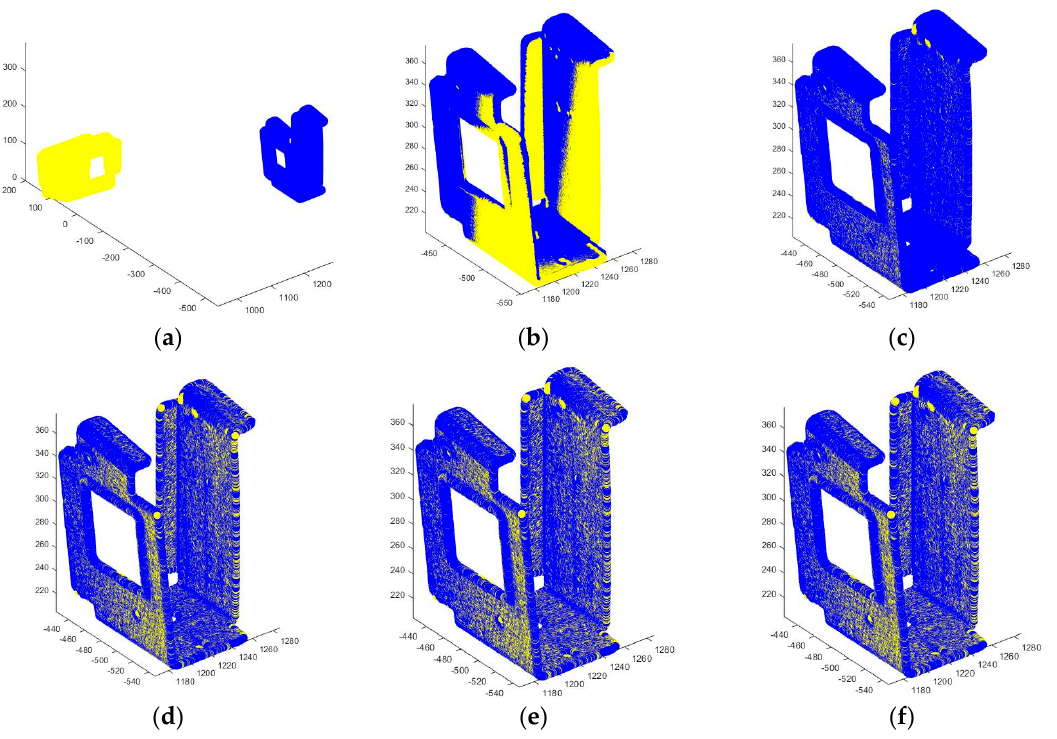
Figure 8. Point cloud fine registration experiment. ( a ) is the initial point cloud data position of the vehicle part, ( b ) is the coarse registration result of FPFH, ( c ) is the fine registration result of ICP, ( d ) is the fine registration result of Harmony search (HS), ( e ) is the fine registration result of Dragonfly algorithm (DA) and ( f ) is the fine registration result of TLBO algorithm. Table 2. PCD after registration in Figure 3a.